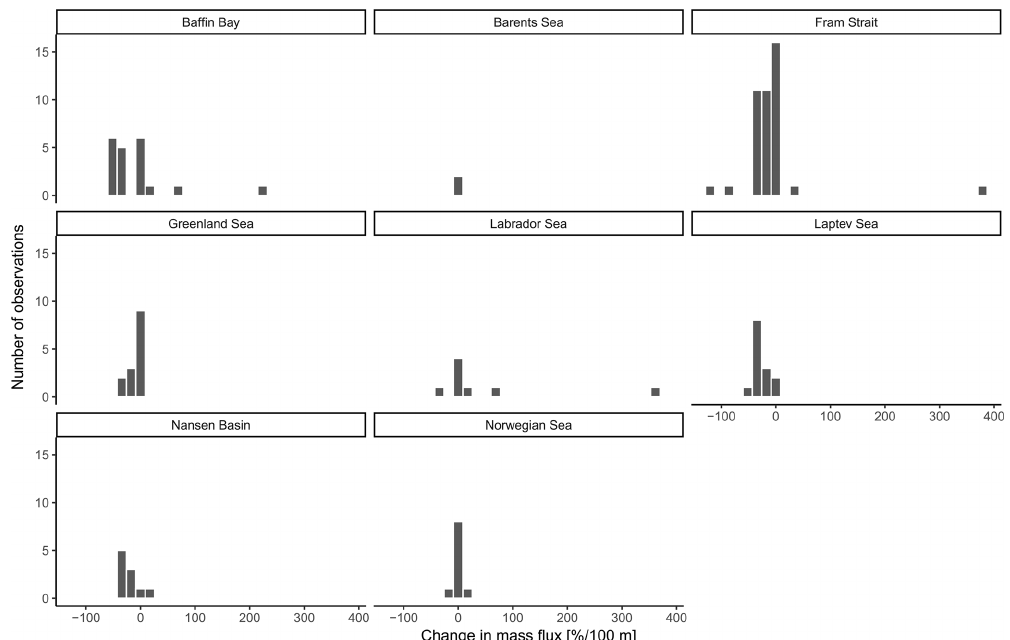
Figure A3. Change in mass flux between the net directly below the calculated base of the productive zone and the deepest net of sampling of each station divided by the different regions of